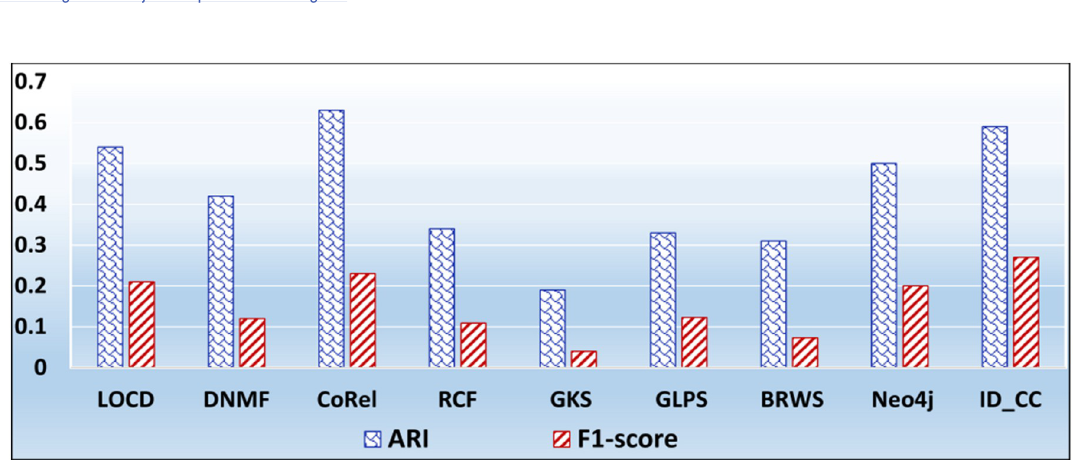
Fig 24. The overall average accuracy of each method for detecting the DBLP cross-communities in terms of ARI and F1-score.